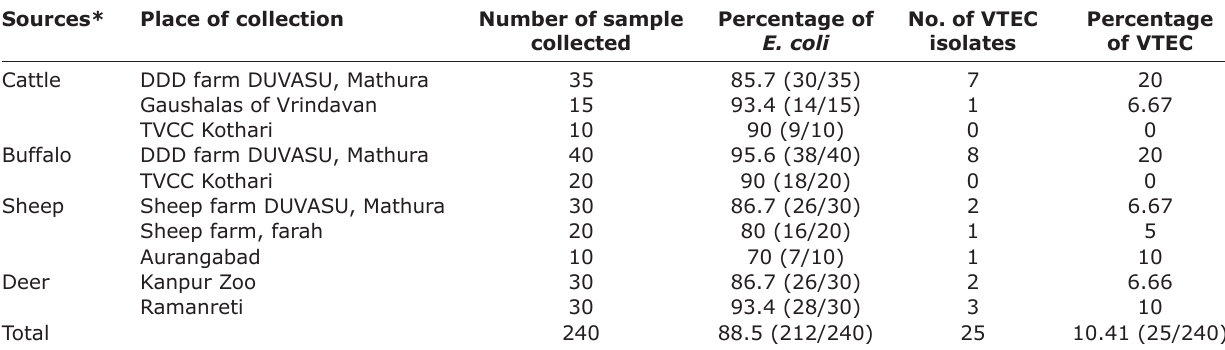
Table-1: Details of sample collection and prevalence of E. coli and VTEC in fecal